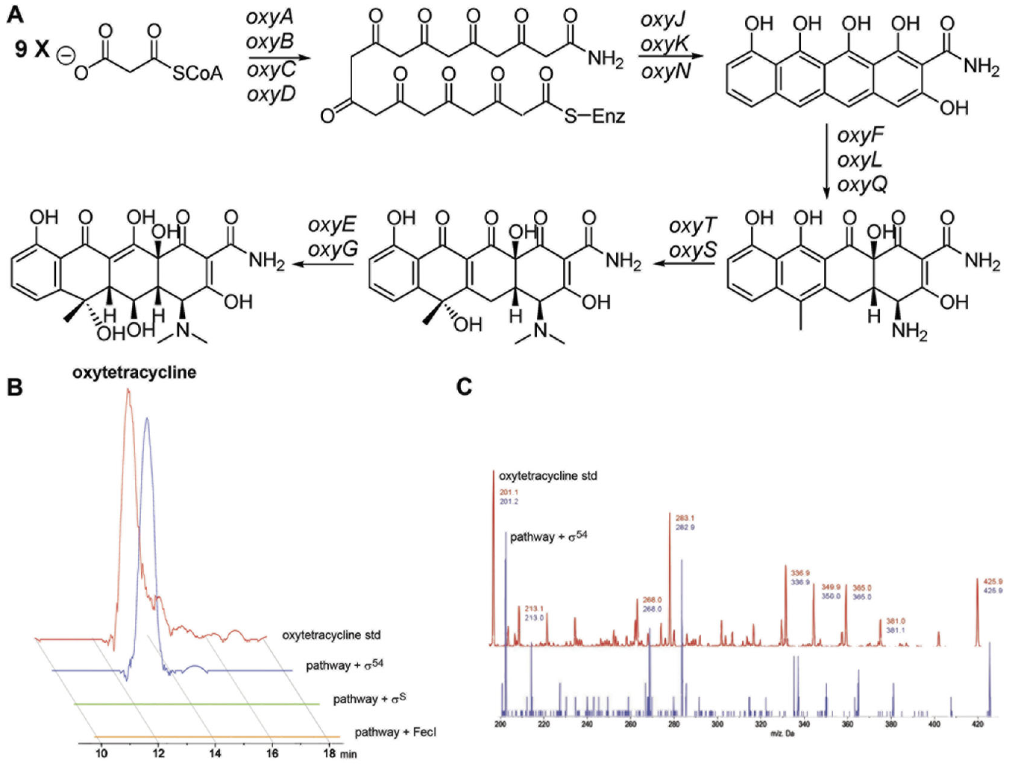
Figure 2. Over-expression of s 54 enables E.coli to heterologously produce oxytetracycline. ( a ) The enzymatic pathway responsible for the biosynthesis of oxytetracycline. ( b ). ESI-LC-MS/MS analysis of an oxytetracycline standard and the organic extracts from E. coli cultures containing the oxytetracycline gene cluster and over-expressing s 54 , s S , or FecI. These traces show the ion extraction data from the Q3 scan of MS/MS experiments. Q1 was used to select the [MH] + ion for oxytetracycline ( m / z =461). Ion extractions were performed for the oxytetracycline fragment m / z =283 from the Q3 scan. Signals with a peak width of less than 0.1 s were regarded as noise and removed with the noise filter application. ( c ). The MS 2 spectrum of the m/z=461 peak for the oxytetracycline authentic standard and heterologously produced oxytetracycline. See also Figure